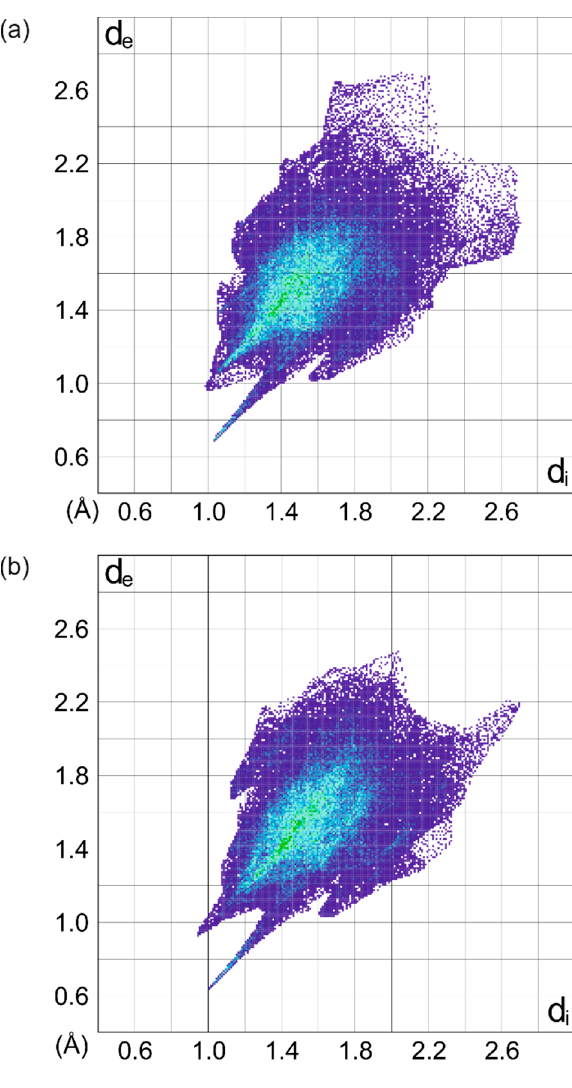
Figure 4. The fingerprints for anions ( a ) A and ( b ) B of compound ( 2 ) at 1.0 GPa [26,27].